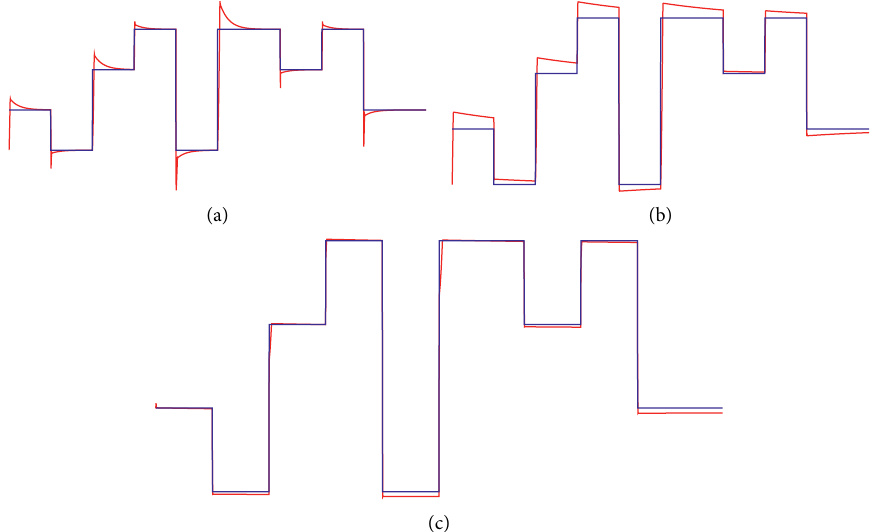
Figure 4: Optimization results using a PSO algorithm with 200 iterations and a population size of 20. Mean square error fitness f (a) equation (1) vs. custom fitness f , (b) equation (2) vs. improved custom fitness f 2 (1)). (b) Overshoot and decay (equation (2)). (c) Overshoot, decay, setting time, and steady-state error as fitness function (equation